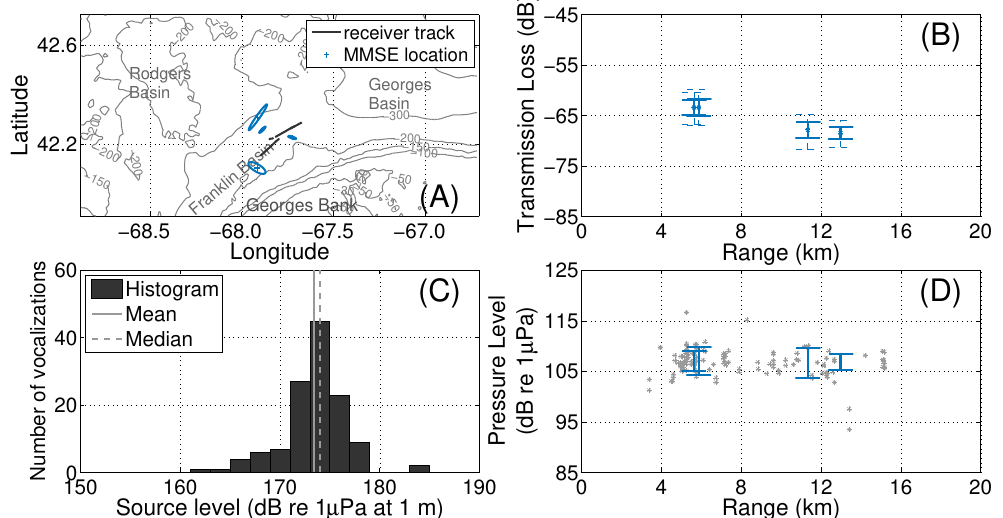
Figure 5. ( A ) The MMSE estimated center locations of sequences of sei whale vocalizations from 4 distinct bearing-time trajectories containing a total of 125 vocalizations; ( B ) Corresponding one-way broadband transmission losses from the MMSE estimated sei whale vocalization sequence center locations to the POAWRS receiver array center. The transmission loss standard deviations (solid bar), minimum and maximum values (dotted bar) are calculated assuming the whales are located at each potential depth from the sea surface to near the seafloor; ( C ) Distribution of sei whale vocalization source level derived from bandpass-filtered beamformed signals has a mean of 173.5 ± 3.2 dB re 1 µ Pa at 1 m; ( D ) The received sei whale vocalization pressure levels estimated from beamformed data plotted as a function of the distance from the estimated instantaneous MAT location of each vocalization to the receiver array center. These data are used to derive the source level distribution shown in ( C ). The blue bars in ( D ) represent one standard deviation in the pressure levels for each bearing-time